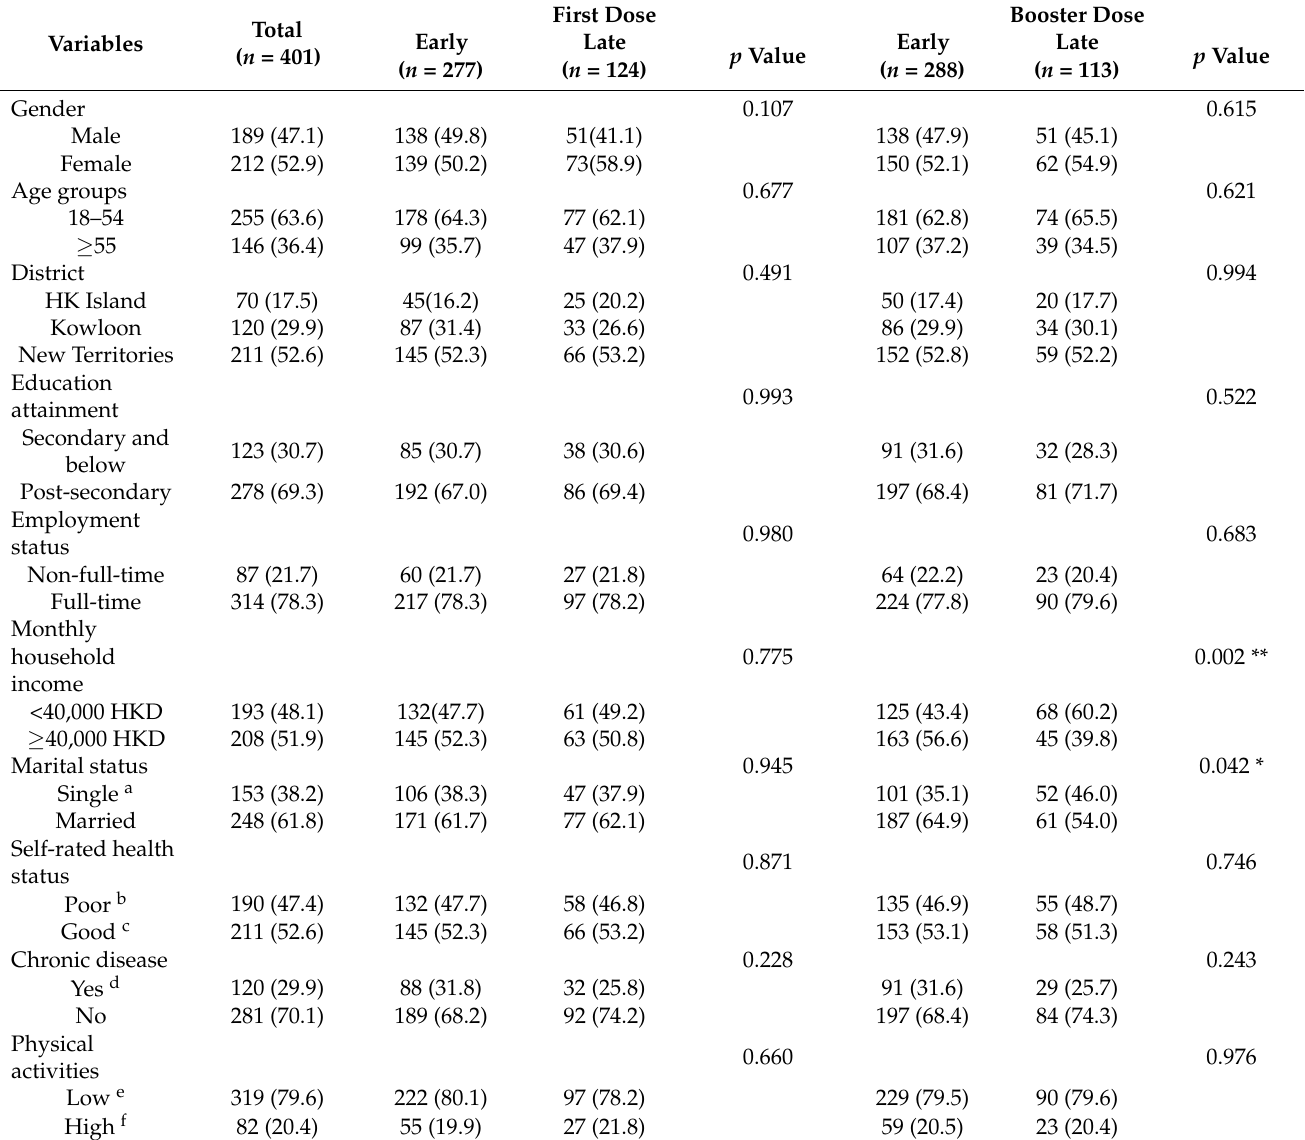
Table 1. Sociodemographic characteristics and health-related factors of participants #